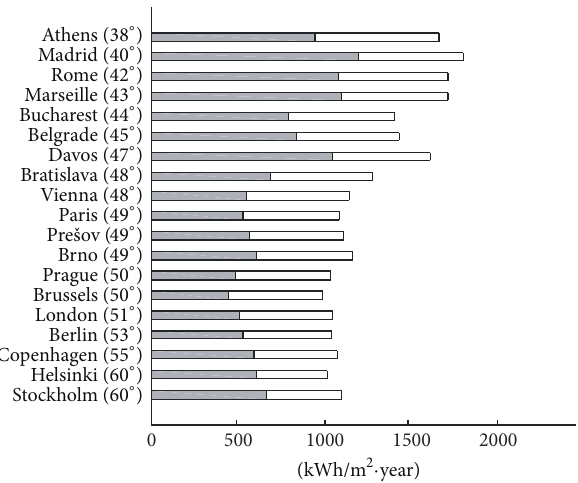
Figure 3: The ratio of a direct (dark) and diffuse (light) solar radiation during a year for the selected cities in Europe [25].